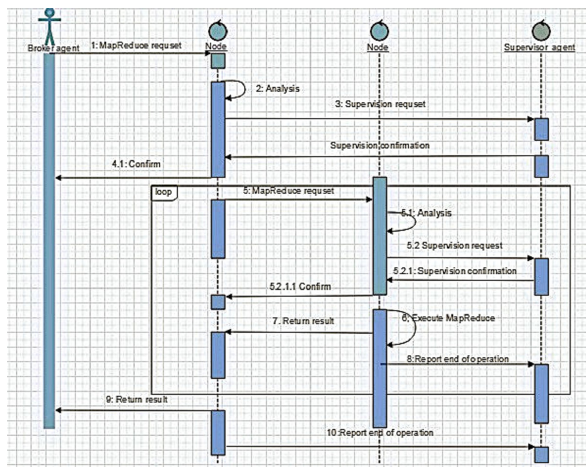
Figure 1: UML Sequence Diagram describes agent interactions when performing a